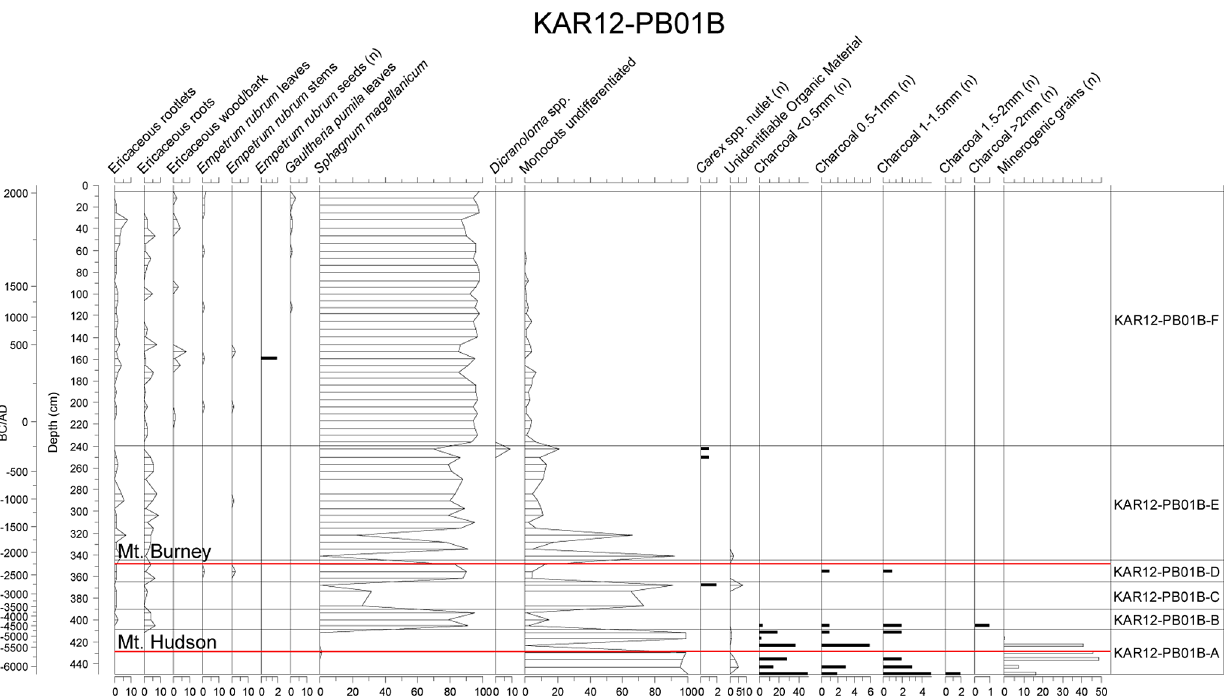
Figure 4. Detailed macrofossil age and depth profile for the Karukinka peat profile. Mineral grains are from the Hudson and Burney tephras (red lines).